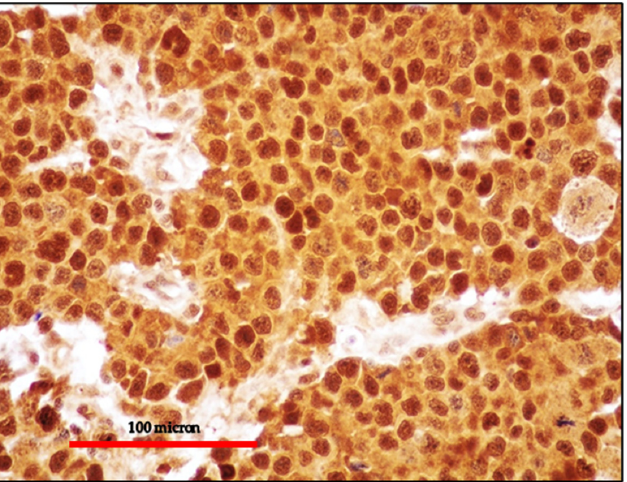
Figure 7. EC ‐ PEL of the ileum: Diffuse and intense expression of MUM18; similar to PBL, EC ‐ PEL expresses markers of plasma cell differentiation (immunostaining, Ventana immunostainer, mag ‐ nification 400×; original image from Prof Ascani).